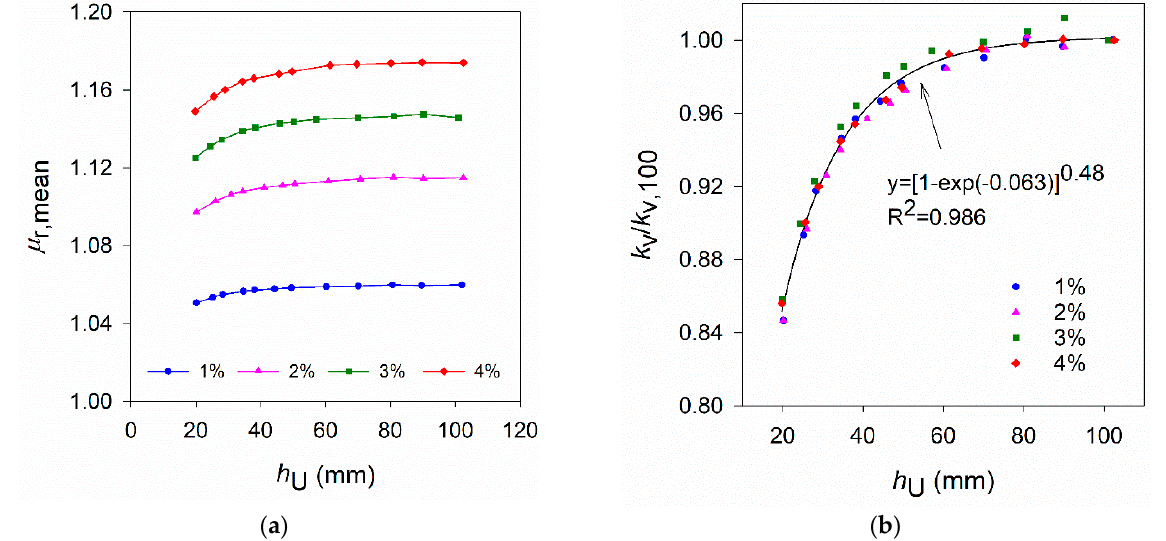
Figure 11. ( a ) Variation of µ r,mean with h U ; ( b ) Variation of k V normalised to k V,100 with h U . Figure 11. ( a ) Variation of μ r,mean with h U ; ( b ) Variation of k (cid:2906) normalised to k (cid:2906),(cid:2869)(cid:2868)(cid:2868) with h U .